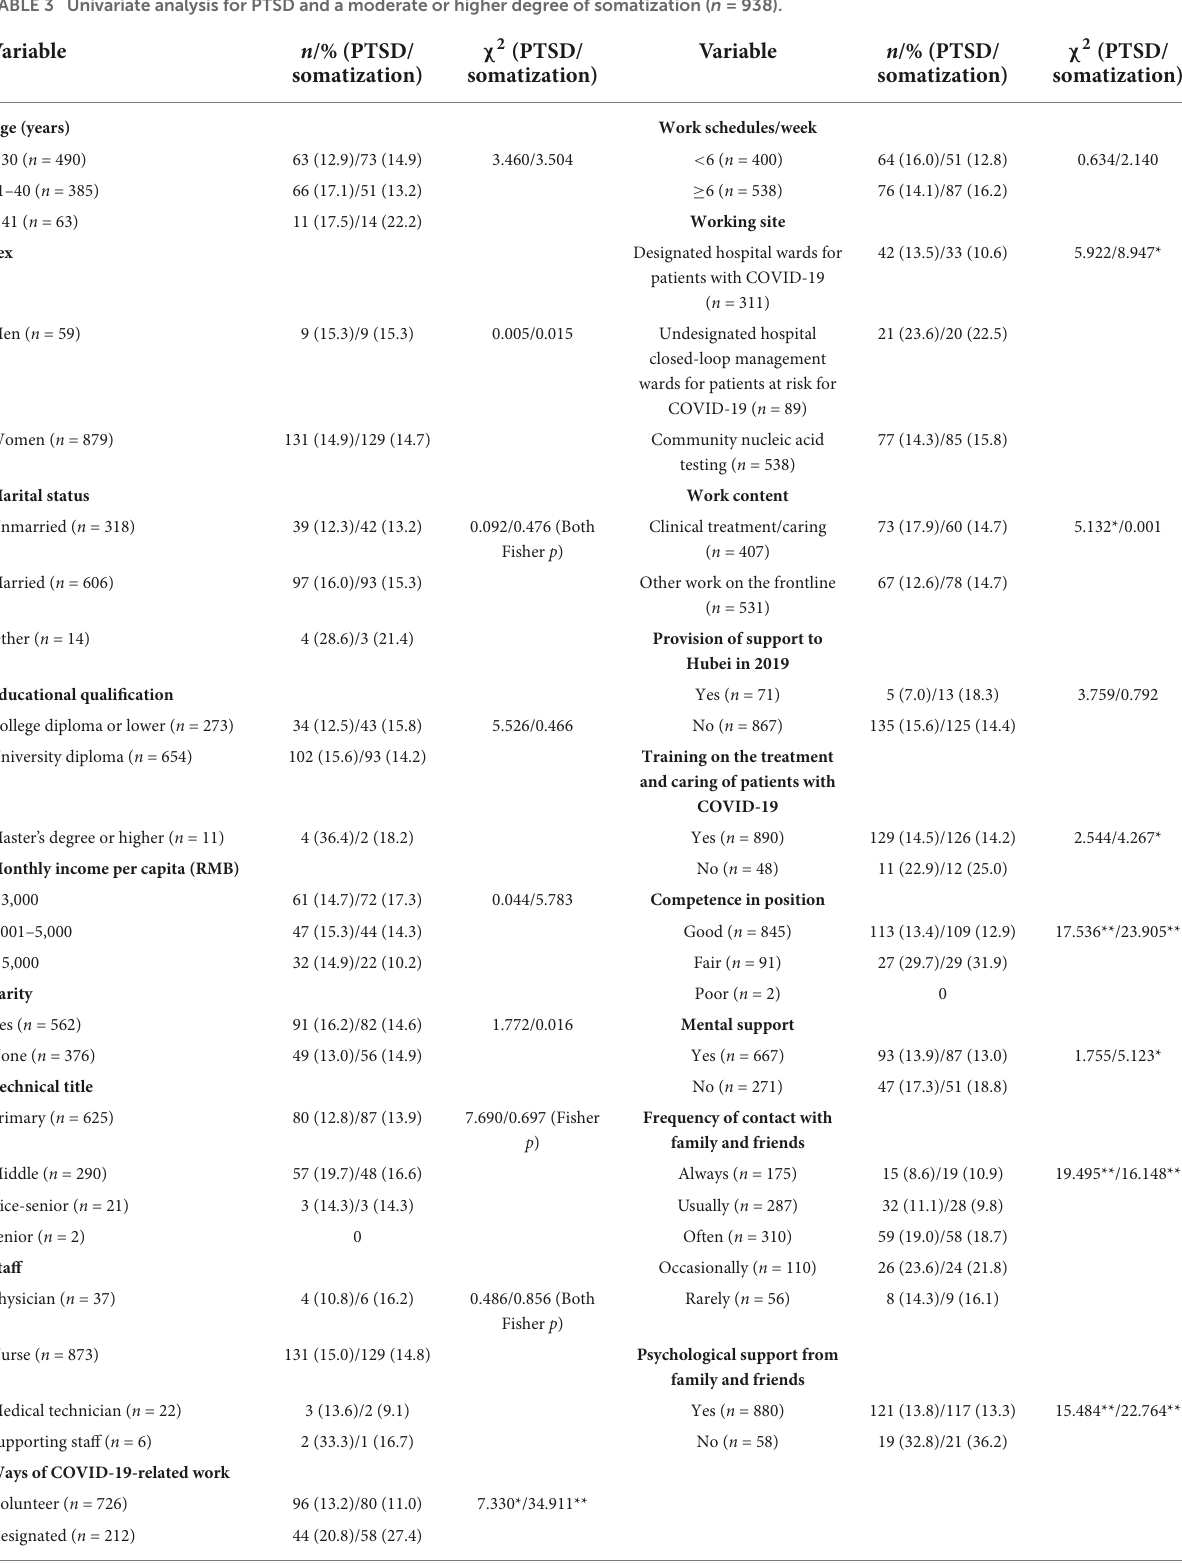
TABLE 3 Univariate analysis for PTSD and a moderate or higher degree of somatization ( n = 938).